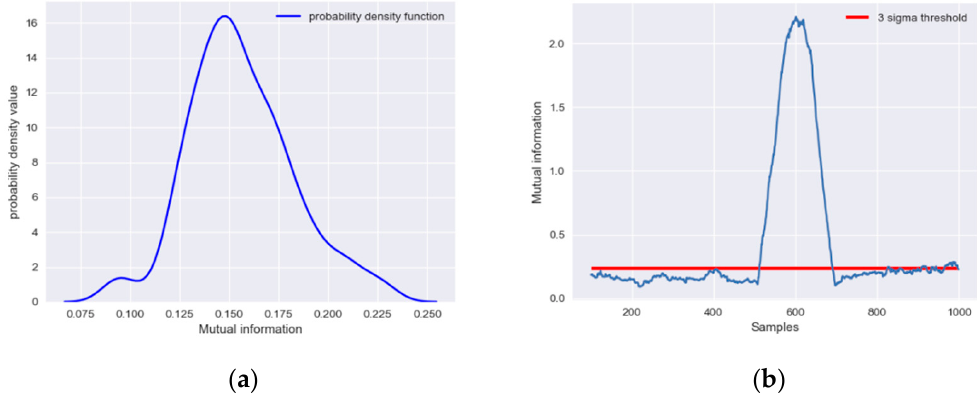
Figure 2. ( a ) Probability distribution of MI under normal conditions; ( b ) MI in each moving window.